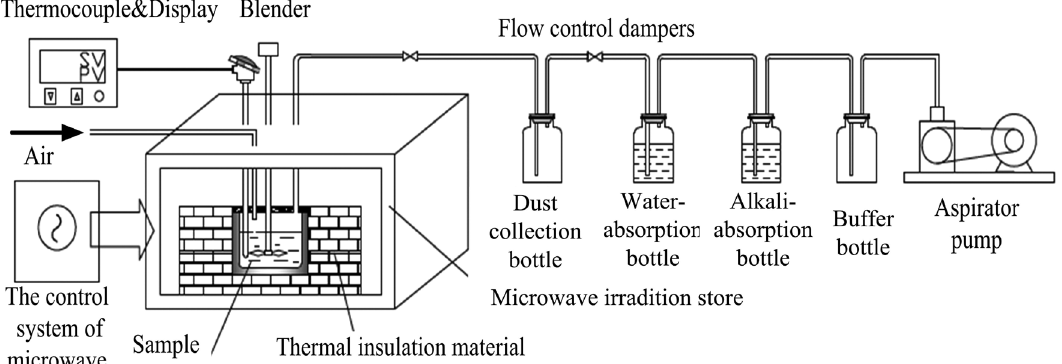
Fig. 4: Connection diagram of microwave roasting experiment equipment